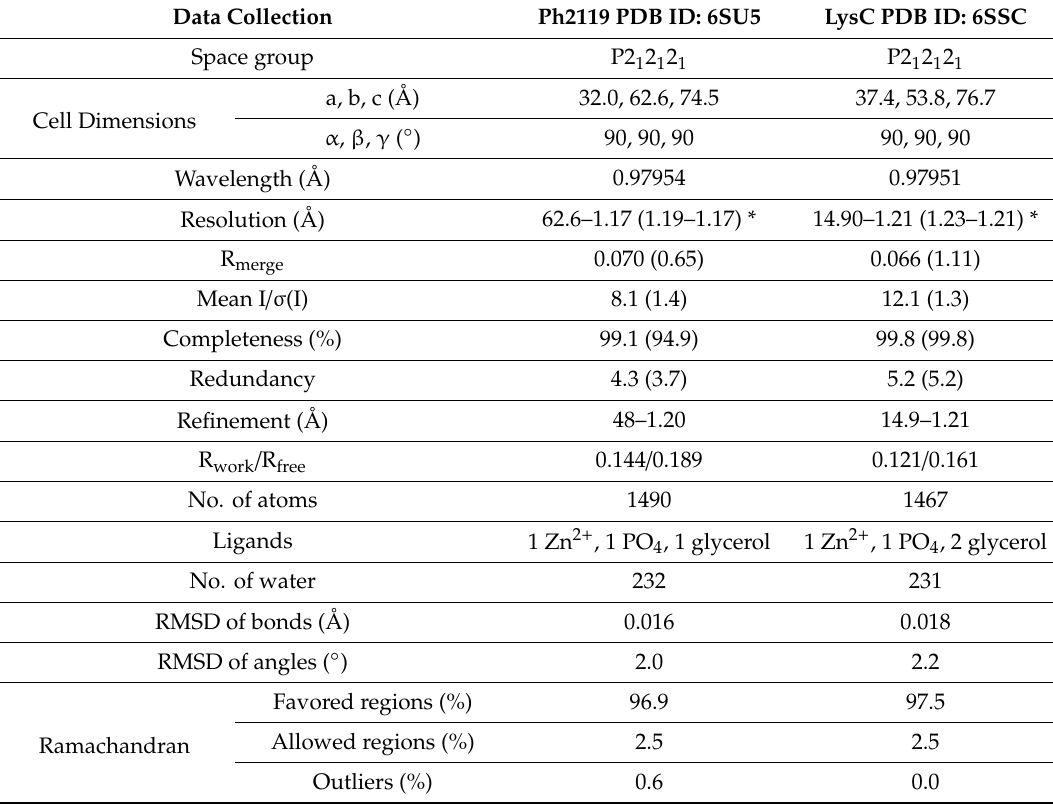
Figure 5. ( A ) Ts2631 endolysin (beige) superimposed on Ph2119 endolysin (blue). Unlike Ts2631, the N -terminus of Ph2119 folds onto itself and does not contribute to dimer stabilization. ( B ) Ph2119 endolysin with Zn 2 + (pink sphere). ( C ) Close view of the Zn 2 + site with coordinating side chains (H30, H132, and C140) and a phosphate group (in sticks representation) shown in two positions with occupancies of 0.8 and 0.2, as indicated by the numbers in the figure. Table 1. Data collection and refinement statistics.